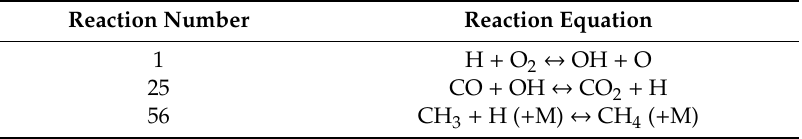
Table 4. Reactions selected for adjusting the laminar flame speed calculation.